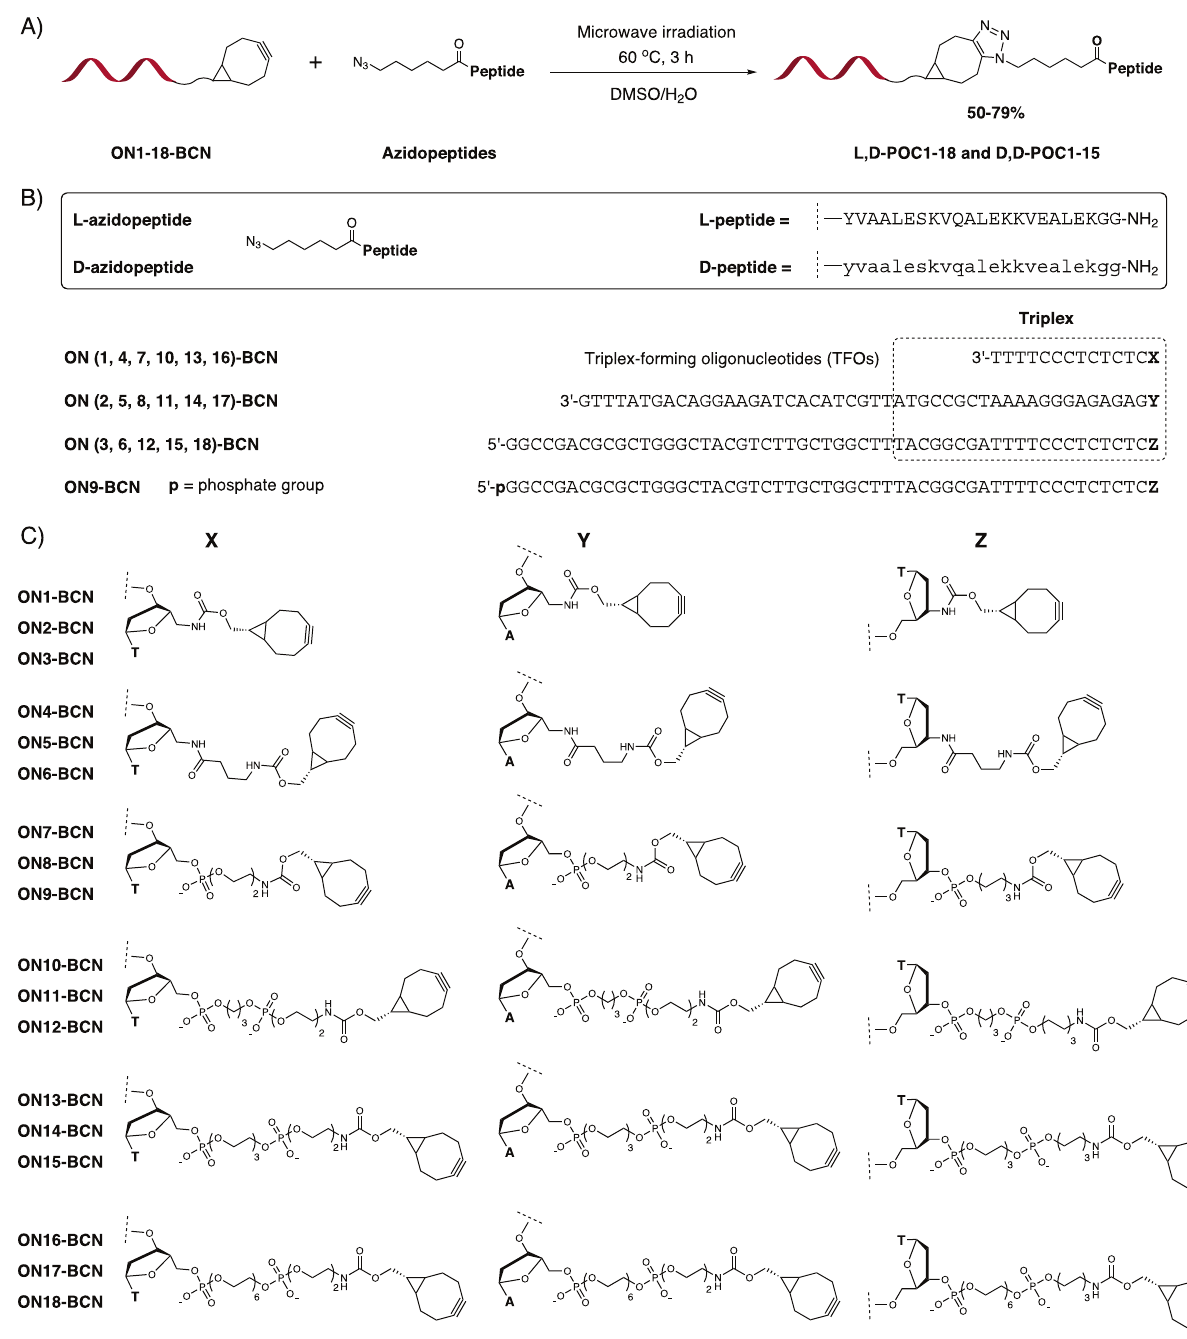
Fig. 2 POC synthesis. A Conjugating two stereoisomeric azidopeptides to ON-BCNs via strain-promoted alkyne-azide cycloaddition to obtain L,D-POC1-18 and D,D-POC1-15 . B Sequence of L-azidopeptide , D-azidopeptide and ONs. C Different linker lengths were employed to furnish the BCN function either on the 5 ′ -end or on the 3 ′ -end of ONs. Natural amino acids are denoted in upper cases while unnatural ones are in lower cases. Thus, Y, V, L, E, S, K, Q, A, G are L-amino acids whereas y, v, l, e, s, k, q, a, g are D-amino acids. A, G, C, and T are natural DNA monomers. Key: The two-letter pre fi x before POCs: The fi rst letter indicates the chirality of the peptide while the second letter indicates the chirality of the